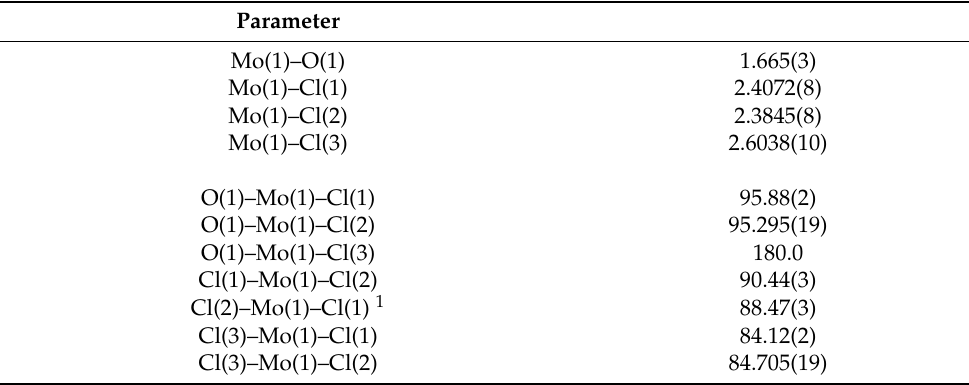
Table 1. Relevant geometric parameters [Å, ◦ ] for the [MoOCl 5 ] 2 − ion of (PyH) 2 [MoOCl 5 ].